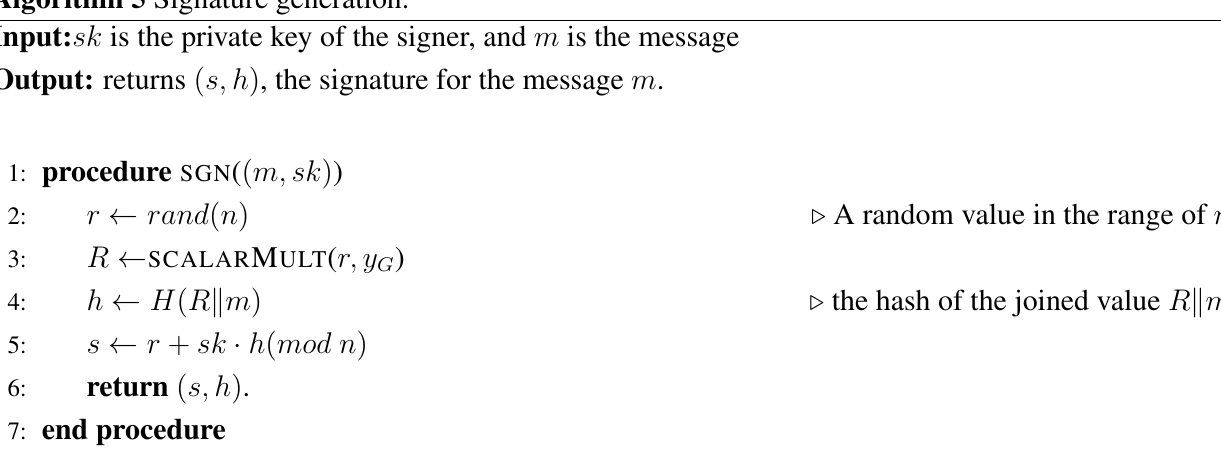
Algorithm 5 Signature